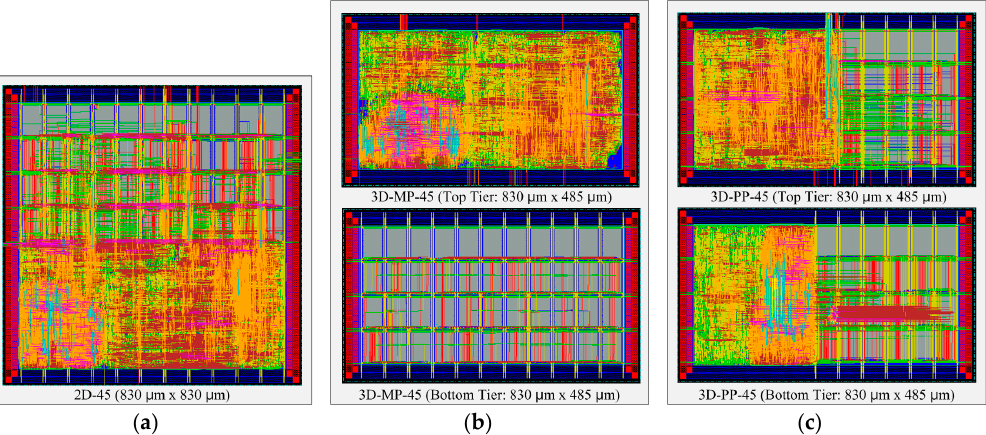
Figure 12. Layout snapshots of 2D and 3D ICs designed in 45-nm process technology: ( a ) 2D IC (2D-45); ( b ) the top and bottom tiers of a 3D IC using macro-level partitioning (3D-MP-45); and ( c ) the top and bottom tiers of a 3D IC using pipeline-level partitioning (3D-PP-45). Table 6. Overall layout results of 2D and 3D ICs designed in 130-nm process technology.